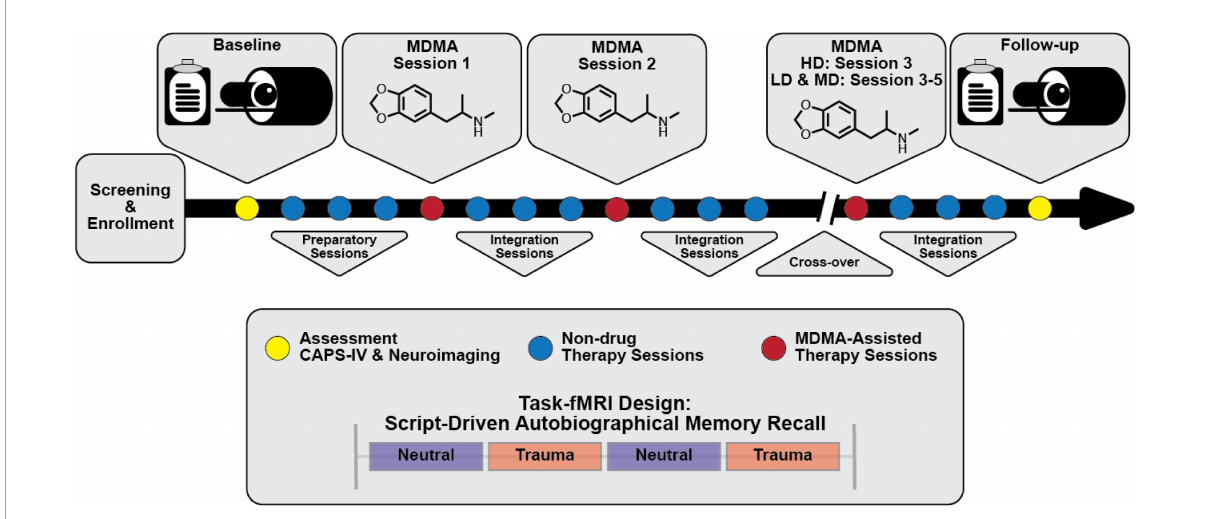
FIGURE1 Simplified study design. Subjects were assessed and imaged at the start of the study (baseline). All subjects [low dose (LD; 30 mg MDMA), medium dose (MD; 75 mg MDMA), and high dose (HD; 125 mg MDMA)] underwent three non-drug preparatory therapy sessions prior to their first MDMA dosing session. Each MDMA session was followed by three non-drug integration therapy sessions. After MDMA session 2 and the subsequent integration sessions, subjects were assessed and the dosing blind was broken. HD subjects completed their final set of drug and non-drug therapy sessions unblinded, and LD/MD subjects crossed over into the HD arm where they completed three sets of drug and non-drug sessions, now with the higher dose and unblinded. All subjects were assessed and underwent MRI approximately two months following their last HD MDMA session. See “2. Methods” section for a full description of study design and scanning